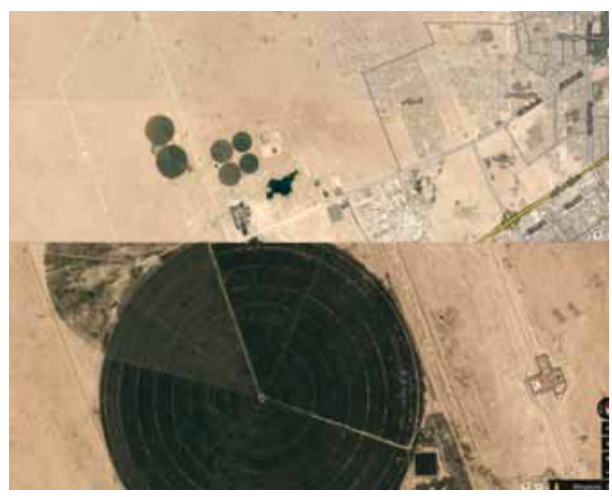
Figure 4 . Green circles in the desert of Qatar source : google maps, 2014